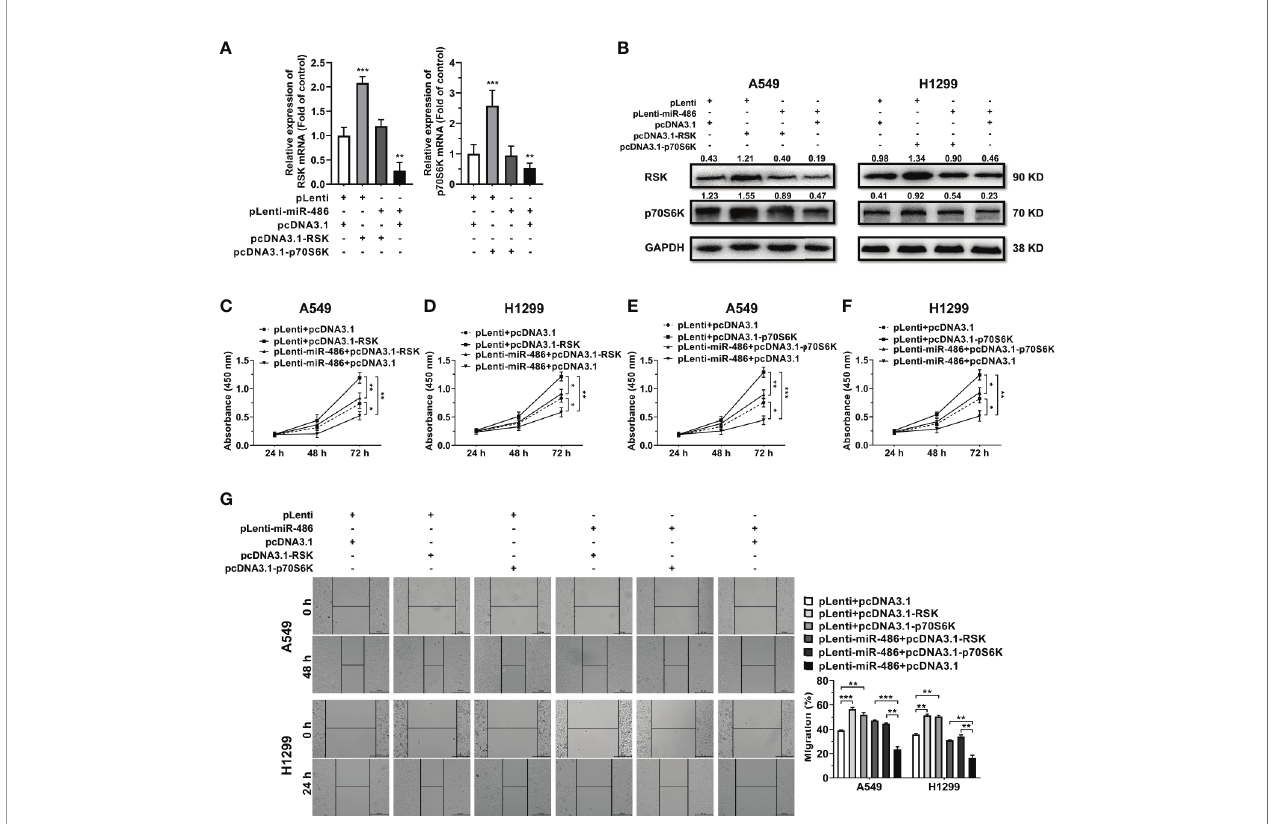
FIGURE 5 | Restoration of RSK/p70S6K rescues the effect miR-486-5p in A549 and H1299 cells. (A, B) The relative RNA (A) and protein (B) expression of RSK/ p70S6K in the pLenti/pLenti-miR-486 transfected A549 and H1299 cells cotransfected with pcDNA3.1-RSK/pcDNA3.1-p70S6K or pLenti vectors. **p < 0.01; ***p < 0.001. (C – G) The effect of RSK/p70S6K restoration on the proliferation (C – F) and migration (G) of A549 and H1299 cells. *p < 0.05; **p < 0.01; ***p <